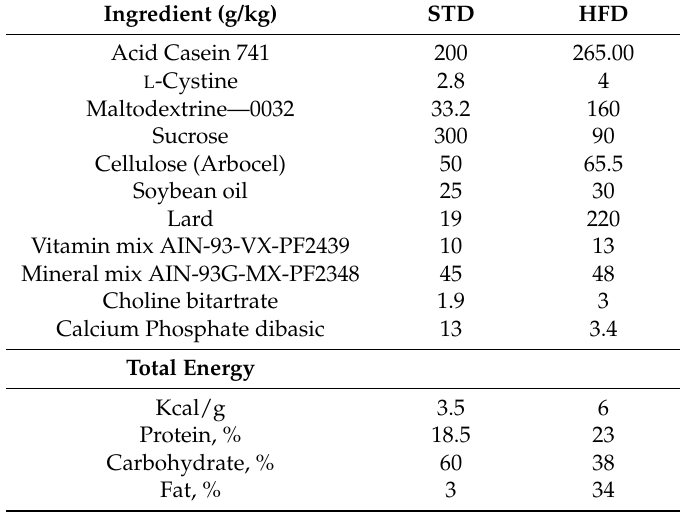
Table 1. Composition and energy densities of standard laboratory diet (STD) and high-fat diet (HFD). Ingredient (g/kg)